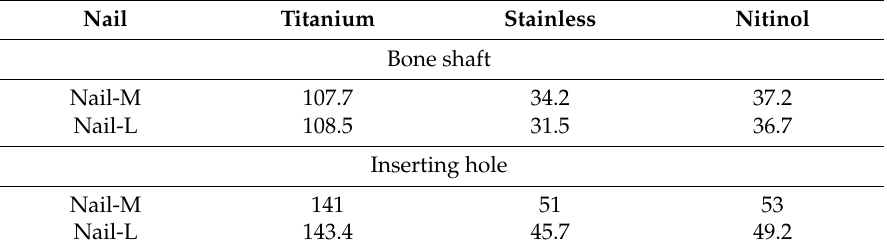
Table 2. Initial contact force (N) between the canal and nails fabricated from various metals.